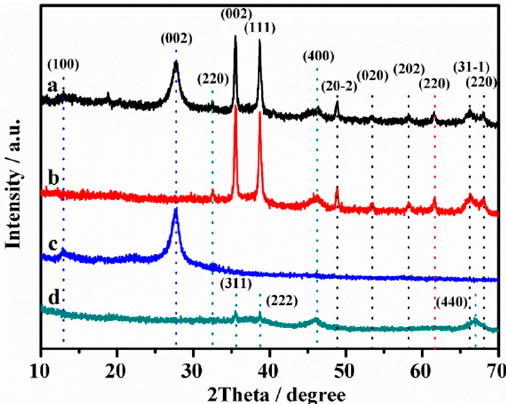
Catalysts 2020 , 10 , 317 Figure 2. XRD patterns of the synthesized samples ( a ) Cu / Al 2 O 3 / CN, ( b ) Cu / Al 2 O 3 , ( c ) CN, and ( d ) Al 2 O 3 . Figure 2. XRD patterns of the synthesized samples ( a ) Cu/Al 2 O 3 /CN, ( b ) Cu/Al 2 O 3 , ( c ) CN, and ( d ) Al 2 O 3 .